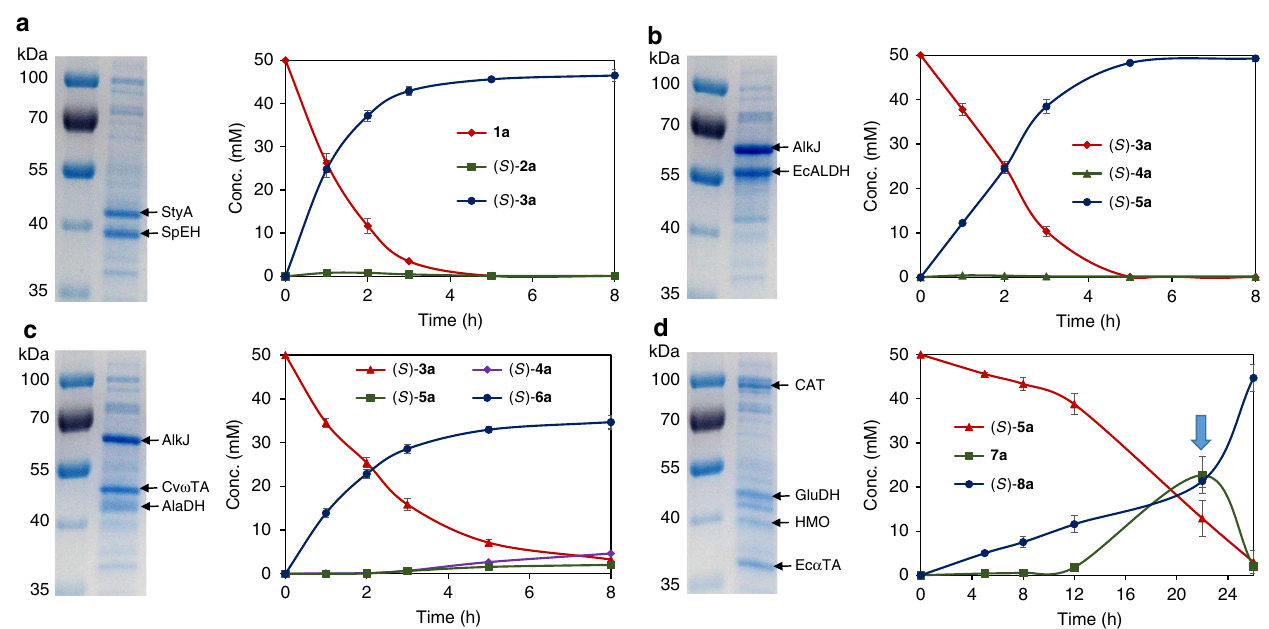
Figure 3 | SDS–PAGE and biotransformation time course of E. coli strains containing individual enzyme modules. ( a ) E. coli (R-M1) cells containing enzyme module 1 (SMO and SpEH); and biotransformation of styrene 1a to ( S )-1-phenyl-1,2-ethanediol 3a . ( b ) E. coli (R-M2) cells containing enzyme module 2 (AlkJ and EcALDH); and biotransformation of ( S )-1-phenyl-1,2-ethanediol 3a to ( S )-mandelic acid 5a . ( c ) E. coli (R-M3) cells containing enzyme module 3 (AlkJ, Cv o TA and AlaDH); and biotransformation of ( S )-1-phenyl-1,2-ethanediol 3a to ( S )-phenylethanolamine 6a . ( d ) E. coli (R-M4) cells containing enzyme module 4 (HMO, Ec a TA, GluDH and CAT); and biotransformation of ( S )-mandelic acid 5a to ( S )-phenylglycine 8a (blue arrow: adding additional 0.5% glucose at 22h). All biotransformations were performed in triplicate, and error bars show ±